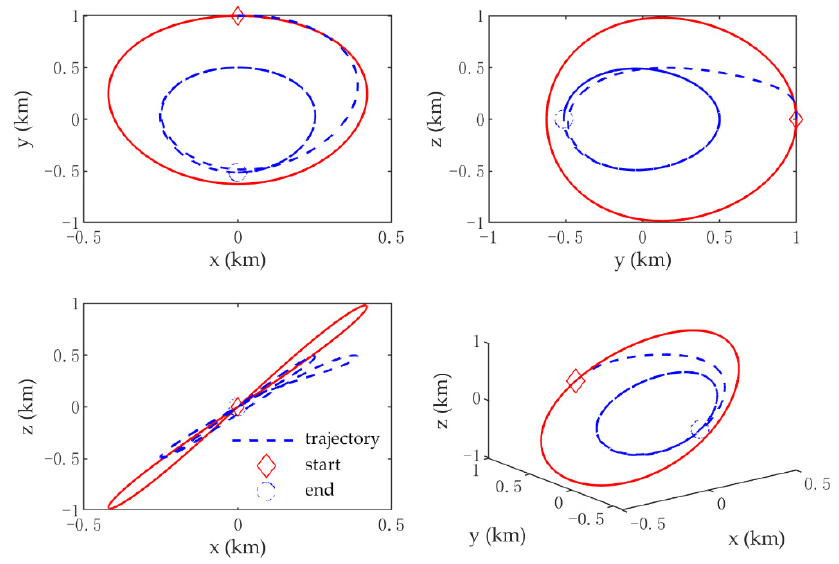
Figure 5. Trajectories of relative transfer orbit and formation for the case without radial control.